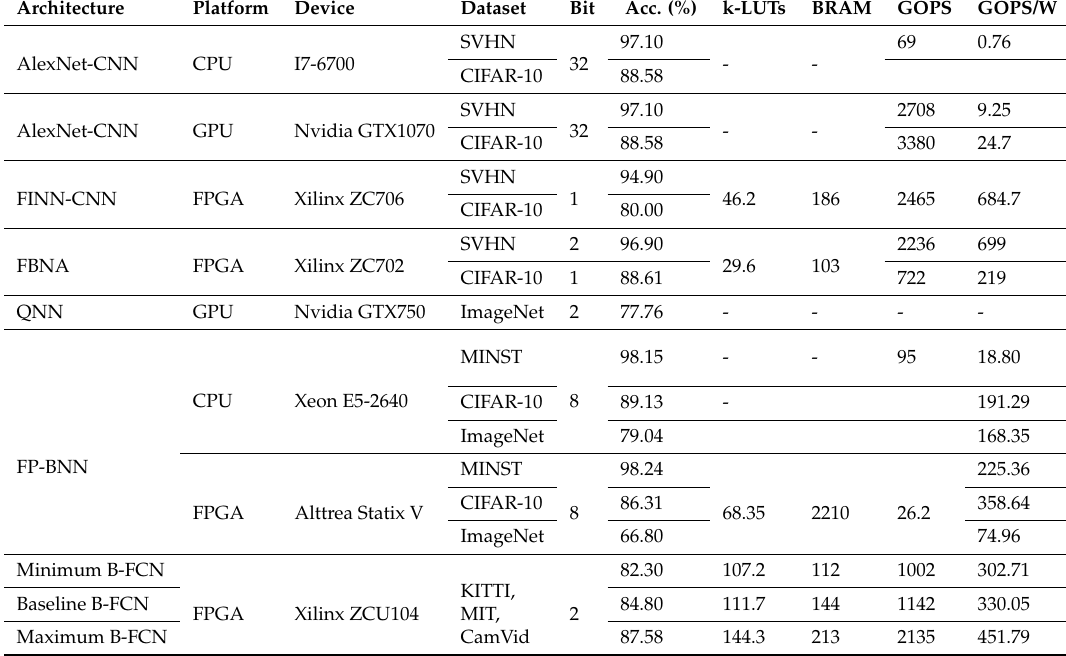
Table 5. Comparison of the design prototype of planing proposal with binary platform using different